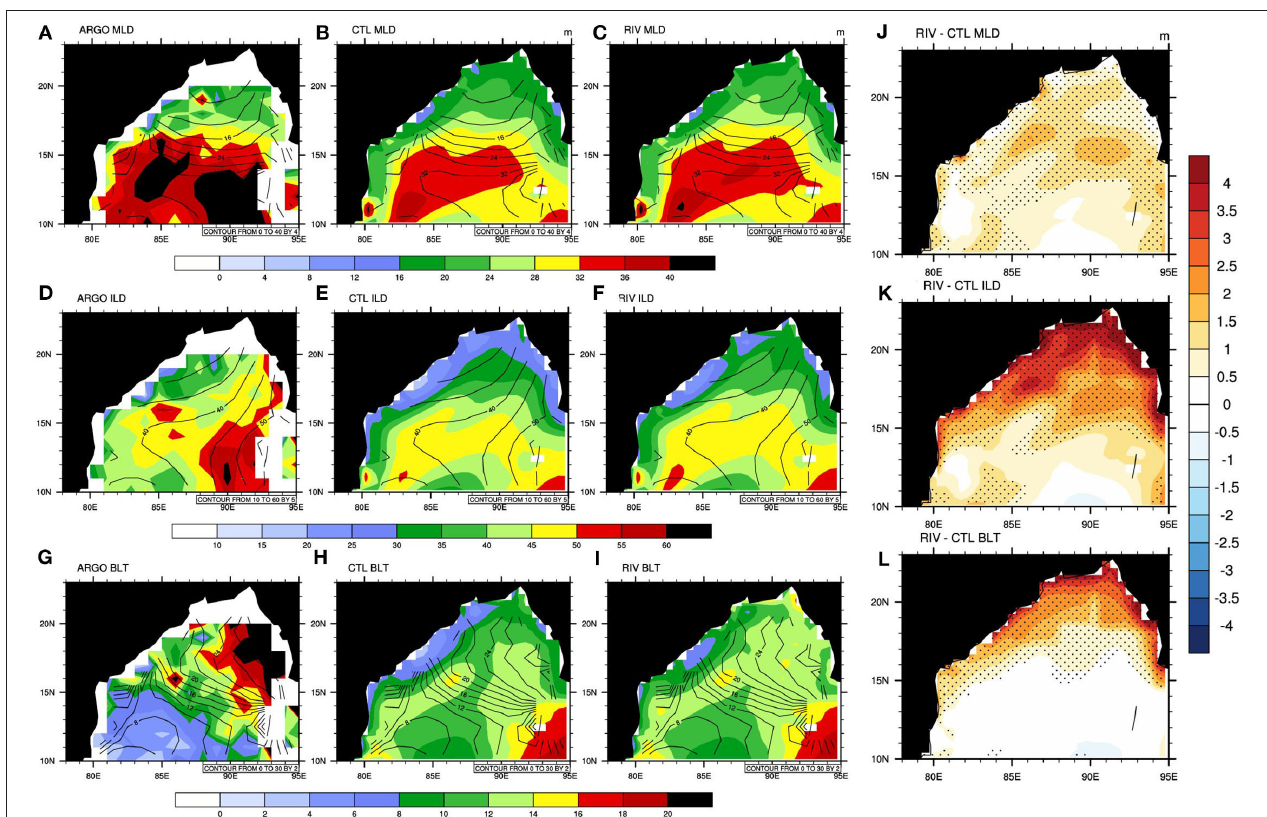
FIGURE 5 | The JJAS mean MLD (in m, shading) for (A) ARGO, (B) CTL run and (C) RIV run. (D–F) and (G–I) Same as (A–C) but for ILD and BLT, respectively. The contours in (A–I) denote the parameters (MLD, ILD, and BLT) calculated from the WOA dataset. The JJAS mean RIV–CTL differences in (J) MLD, (K) ILD, and (L) BLT. Differences significant at 90% confidence level are stippled in (J–L)